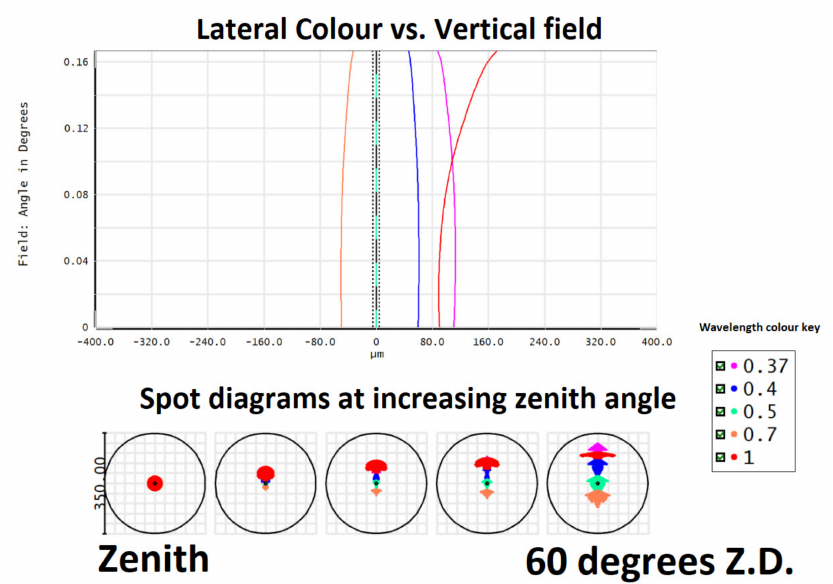
Figure 7. ( Top ) Lateral colour vs. field plot for the CL-ADC proposed design for the GMT C-ADC. ( Bottom ) Spot diagrams correspond to those in Figure 6. These plots show that the sign of the residual secondary spectrum is of opposite sign to that shown in Figure 6.